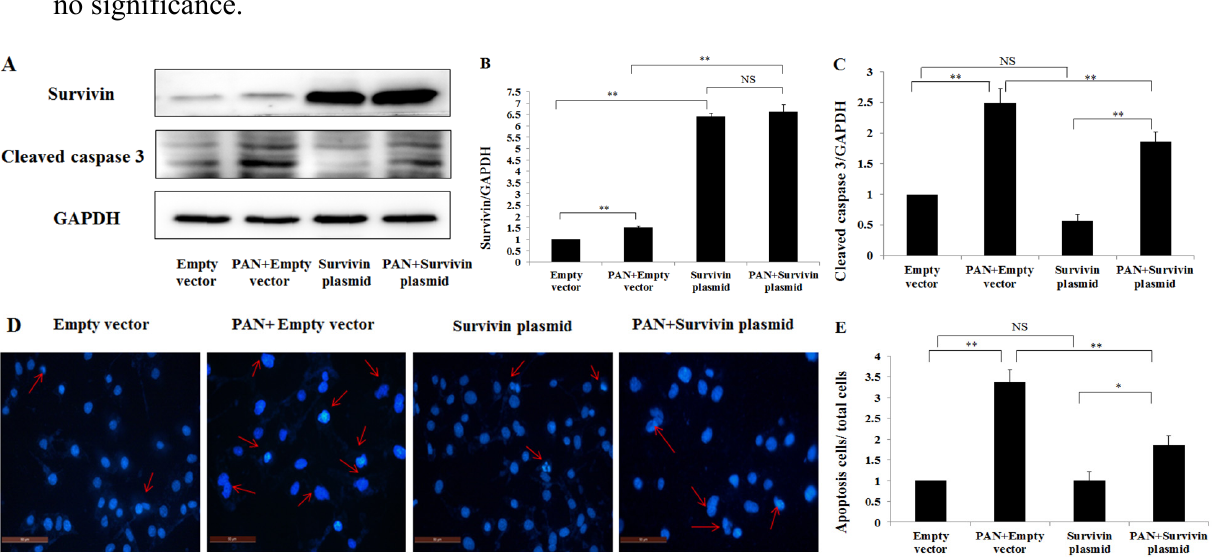
Figure 5. The effect of over-expressed survivin on PAN-induced injury of poodcytes. ( A ) Total cell lysates were analyzed via western blot with antibodies against survivin, cleaved caspase 3 and GAPDH; ( B , C ) The amounts of each protein were quantified and calibrated with the expression of GAPDH; ( D ) Images of podocytes stained with Hoechst (200×, original magnification), Bar = 50 μ m. Hoechst staining shows nuclei of apoptosis and living cells. Red arrows indicate apoptotic cells; ( E ) Quantitative analysis of apoptosis cells was shown as apoptosis cells/total cells; ( F ) Images of podocytes stained by TUNEL. Bar = 100 μ m. The green color is indicative of TUNEL-positive cells (indicated with red arrows), and the blue color marks the presence of all cells; ( G ) The percentage of apoptotic cells is reported. For each group in a given experiment, at least 300 randomly chosen cells were analyzed; ( H ) MTS analysis of the rate of podocytes viability; ( I ) F -actin and survivin staining with the fluorescence study demonstrates in red and green,